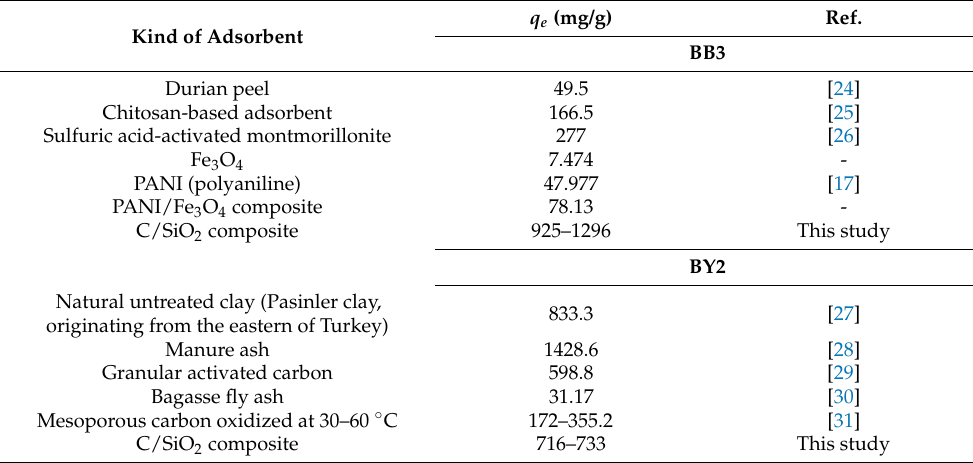
Table 4. Comparison of adsorption capacity of different adsorbents towards BB3 and BY2. q e (mg/g) Kind of Adsorbent